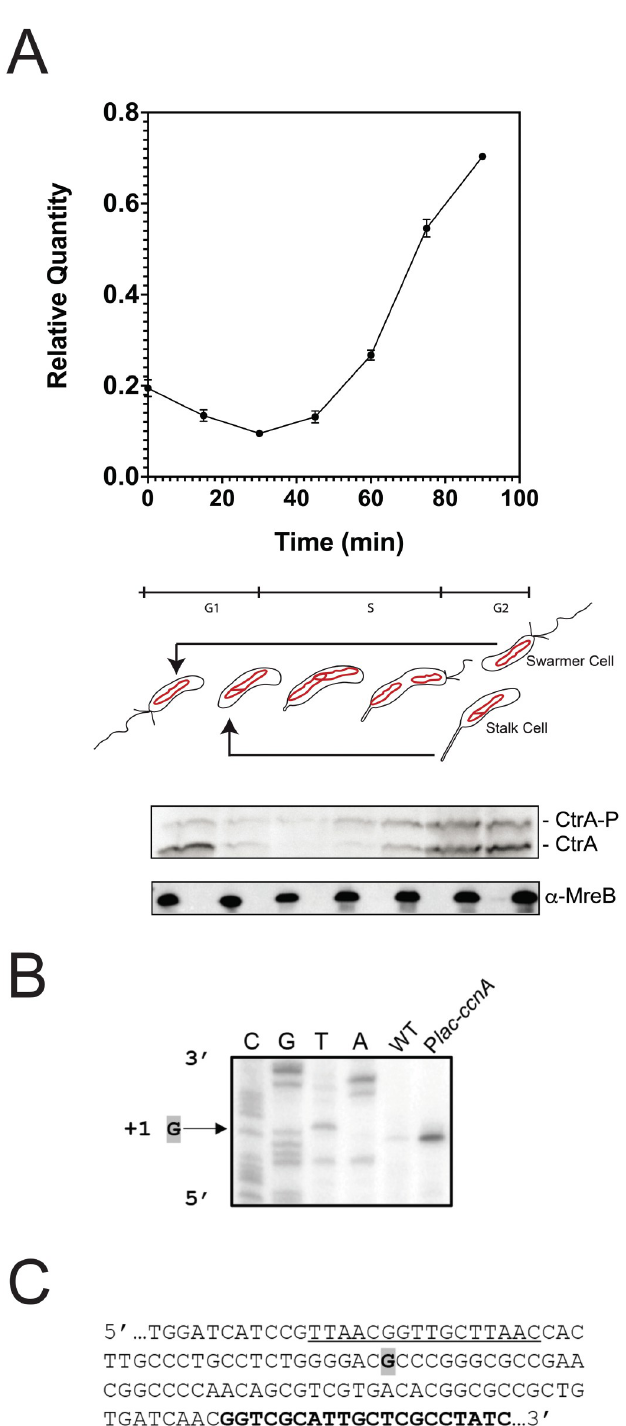
Fig 1. CcnA is a cell cycle–regulated ncRNA. ( A) Expression level of CcnA during the cell cycle of WT cells C . crescentus . Cells were grown in PYE until OD 600nm = 0.6 then synchronized according to material and methods. Total RNA was extracted at indicated time points of the cell cycle. Expression of CcnA was then determined by qRT-PCR in comparison to 16S rRNA level. Results are shown as mean ( N = 3) +/ − SD. Data are in S9 Table. Proteins corresponding to the same time points were extracted and separated on a SDS-PAGE gel containing Phostag and Mn 2+ to visualize CtrA phosphorylation. CtrA (Phostag) and MreB (in a normal Western blot) were revealed using